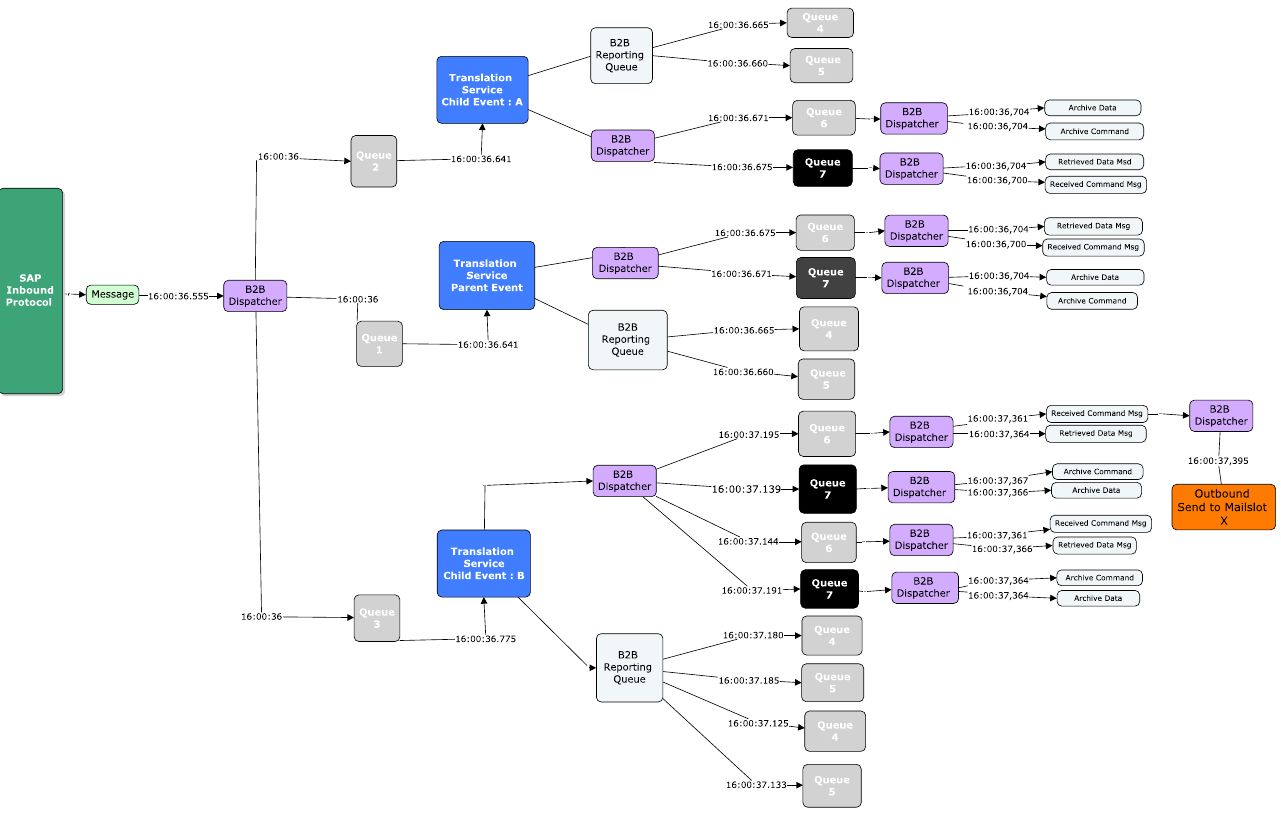
Figure 3. Message traversal through the supply chain